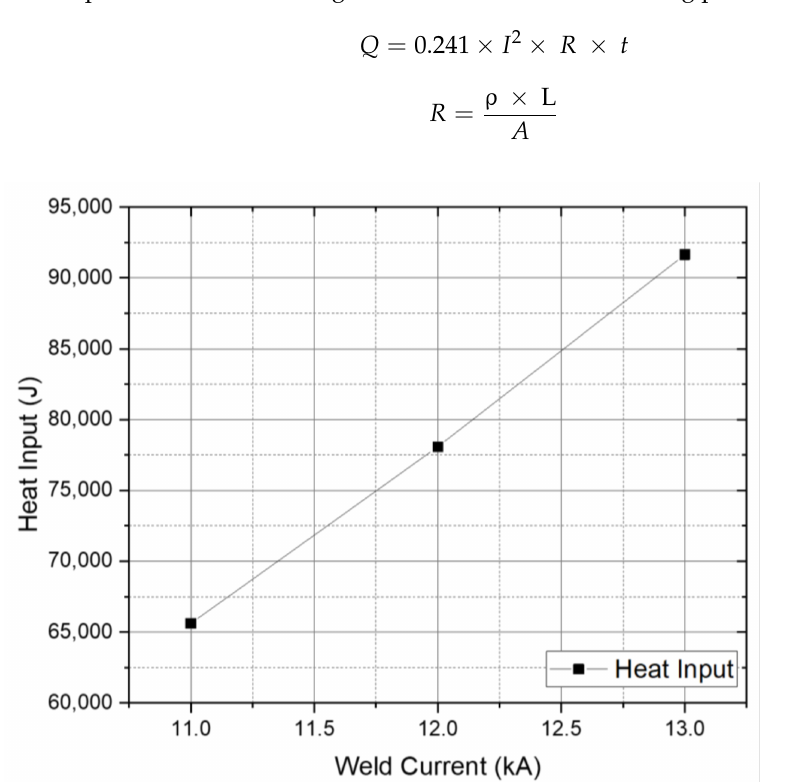
Figure 2. Generated heat input at different welding